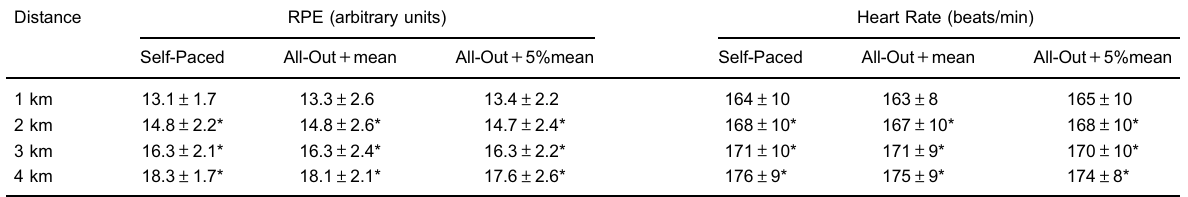
Table 2. Ratings of perceived effort (RPE) and heart rate responses during a 4-km cycling time trial adopting different pacing strategies. Distance RPE (arbitrary units) Heart Rate (beats/min) Self-Paced All-Out + mean All-Out + 5%mean Self-Paced All-Out + mean All-Out +